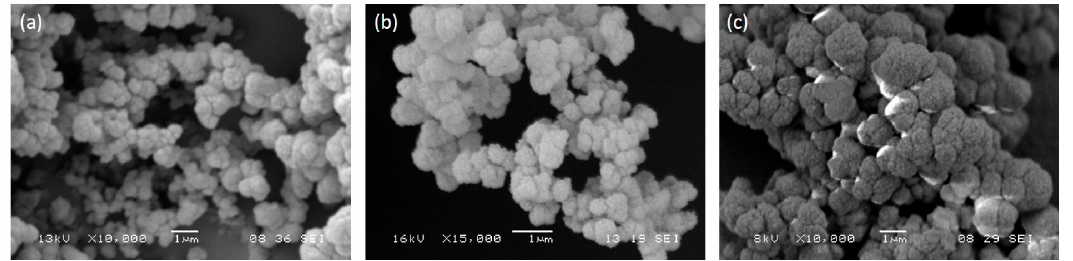
Figure 1. SEM micrographs of MIP-GRGDSP ( a ), MIP-YIGSR ( b ), and CP ( c ). Images were acquired at different magnifications, as reported by scale bars. CP: control particles, MIP: molecularly imprinted particles.